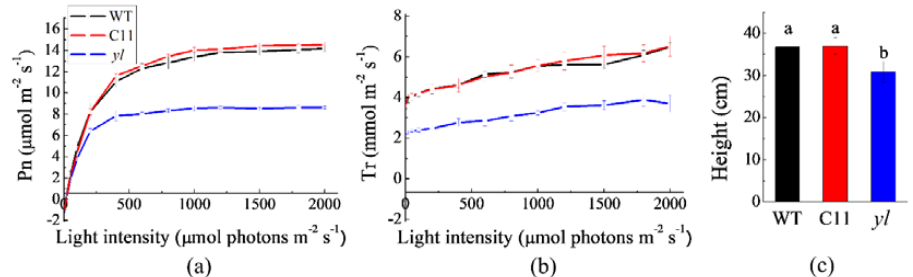
Figure 3. Photosynthetic and growth performance of WT, C11, and yl lines. Photosynthetic rate ( a ) and transpiration rate ( b ) of WT, C11, and yl. Error bars represent the SD of three measurements. ( c ) Plant height of WT, C11, and yl . Error bars represent the SD of 40 measurements. Table 2. The correlation analysis of transpiration rate (Tr), stomatal conductance (Gs), and Pn in WT, C11, and yl . ** Correlation is significant at the 0.01 level (2-tailed).